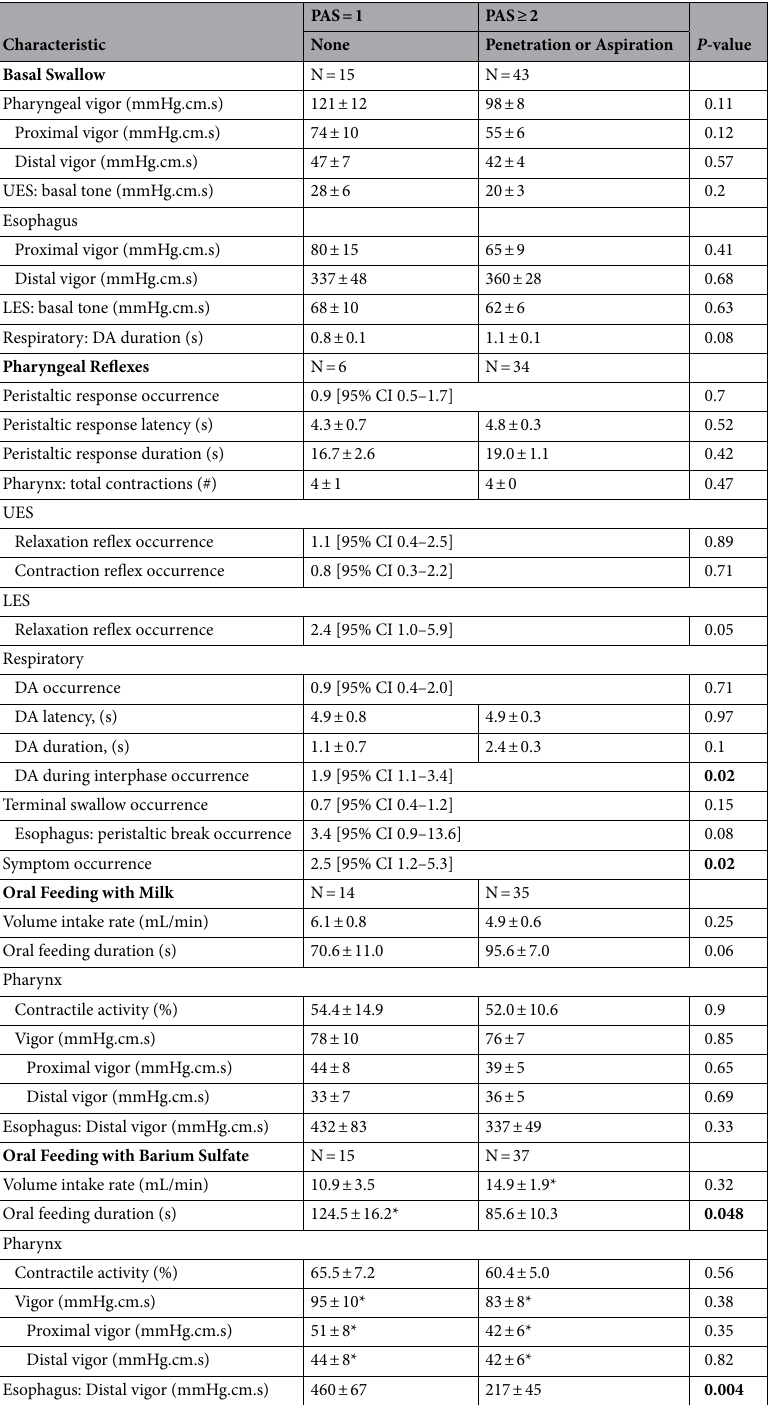
Table 4. Comparison of HRM motility characteristics in study infants with and without penetration or aspiration. Data presented as Mean ± SE or Odds Ratio [95% CI] with PAS = 1 used as reference group for Odds Ratios. Interpretation example: infants with penetration or aspiration are 2.5 times more likely to have symptoms than those without penetration or aspiration. UES- upper esophageal sphincter, LES- lower esophageal sphincter, DA- deglutition apnea. * p < 0.05 versus oral feeding with